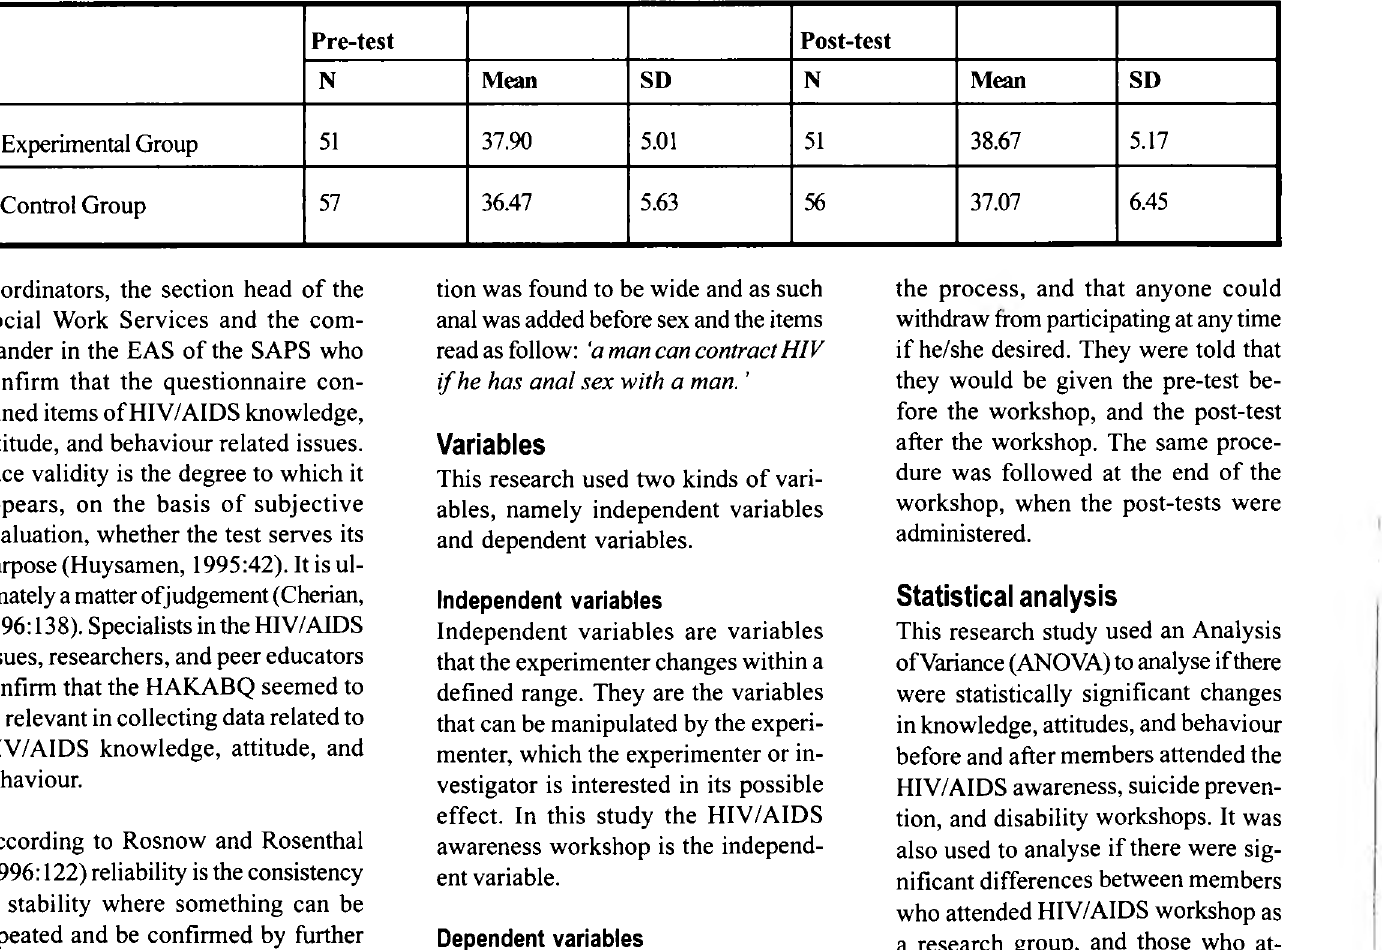
Table 4: Pre- test and post-test of HIV/AIDS attitudes scores for experimental and control